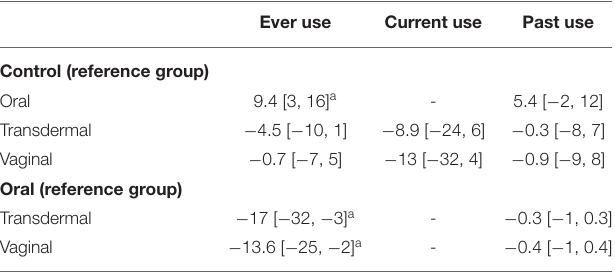
TABLE 3 | Multi-variate analysis of SBP by route of administration of hormone therapy type presented as beta coefficients, [95% CI].